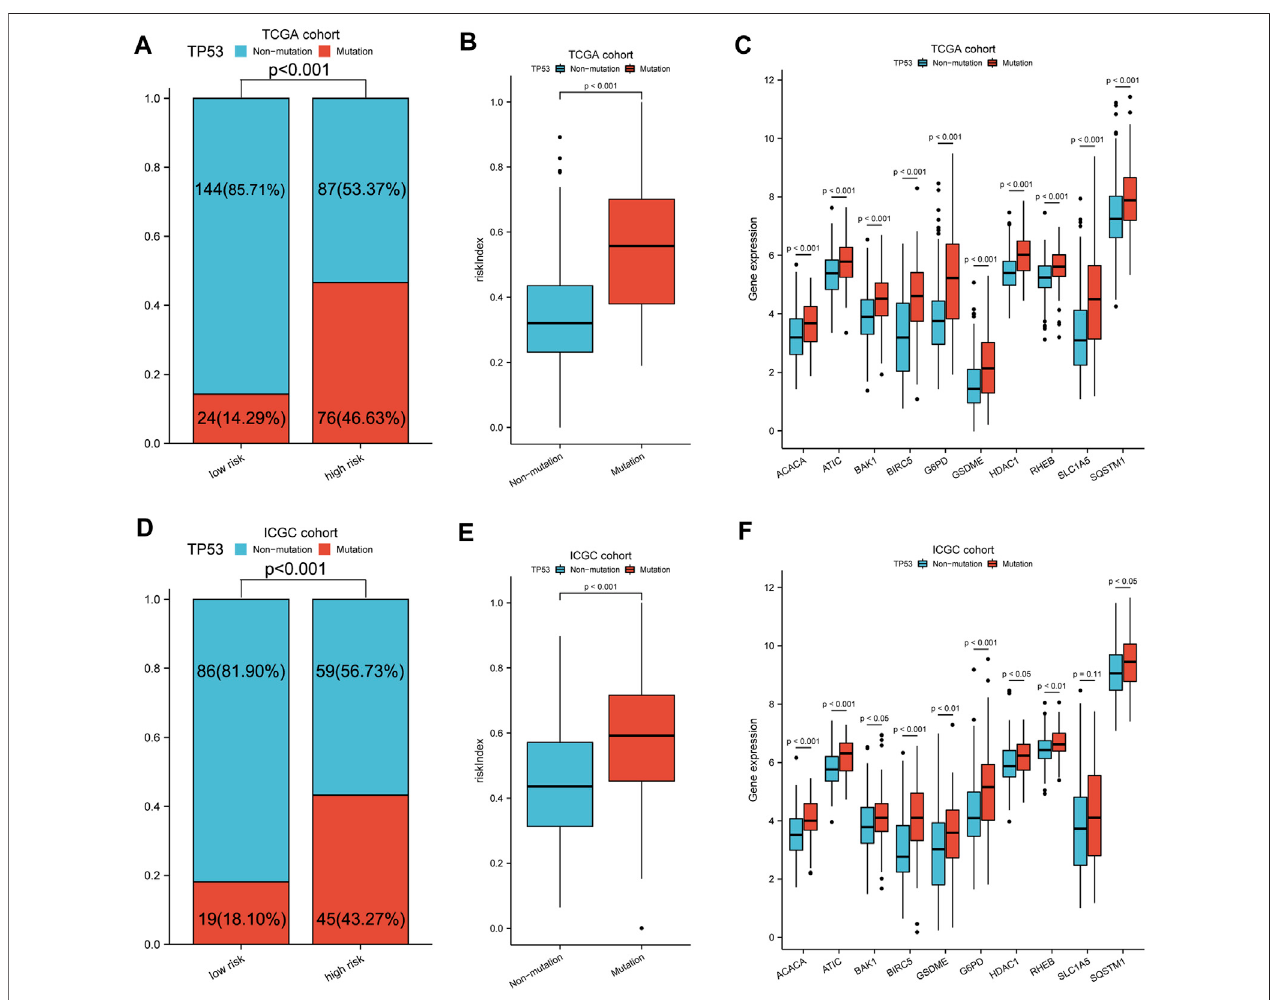
FIGURE 4 | TP53 mutation analysis of different subgroups. (A,D) Comparison of TP53 mutation proportion in different subgroups. (B,E) Risk index and (C,F) 10- model gene expression between TP53 mutation and non-mutation group. A – C: TCGA cohort, D – F: ICGC cohort.